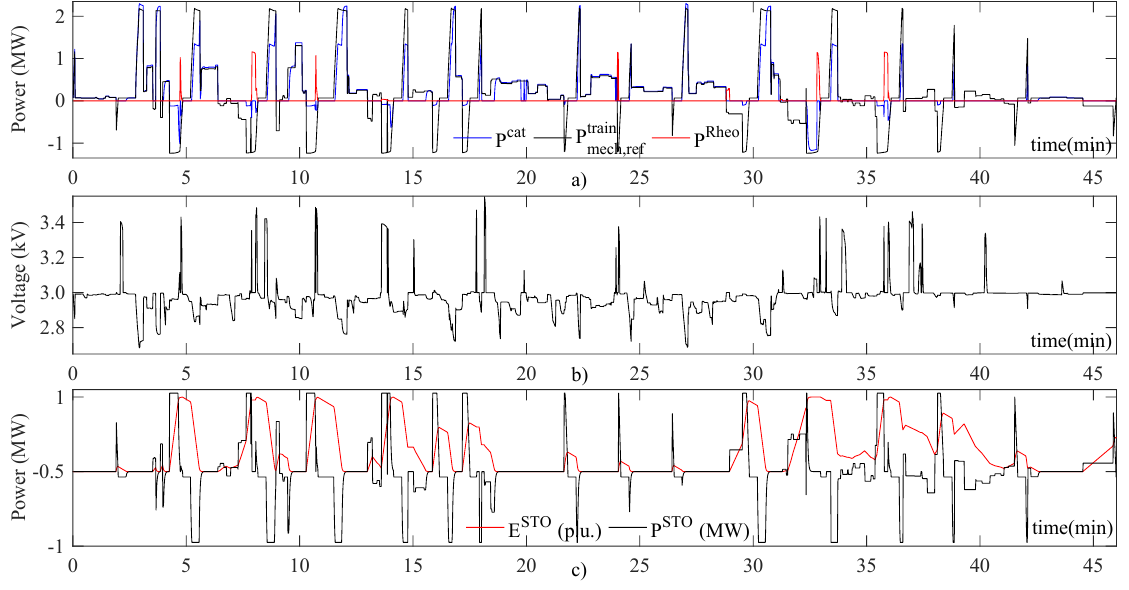
Figure 4. Detailed behavior of the fourth train on the red line from S1 to S6 in the light traffic scenario with on-board energy storage. ( a ) Mechanical reference power; power extracted from the catenary and burned in the rheostatic system. ( b ) Catenary voltage. ( c ) Storage system power (in black) and state of charge of the energy storage system (in red) in